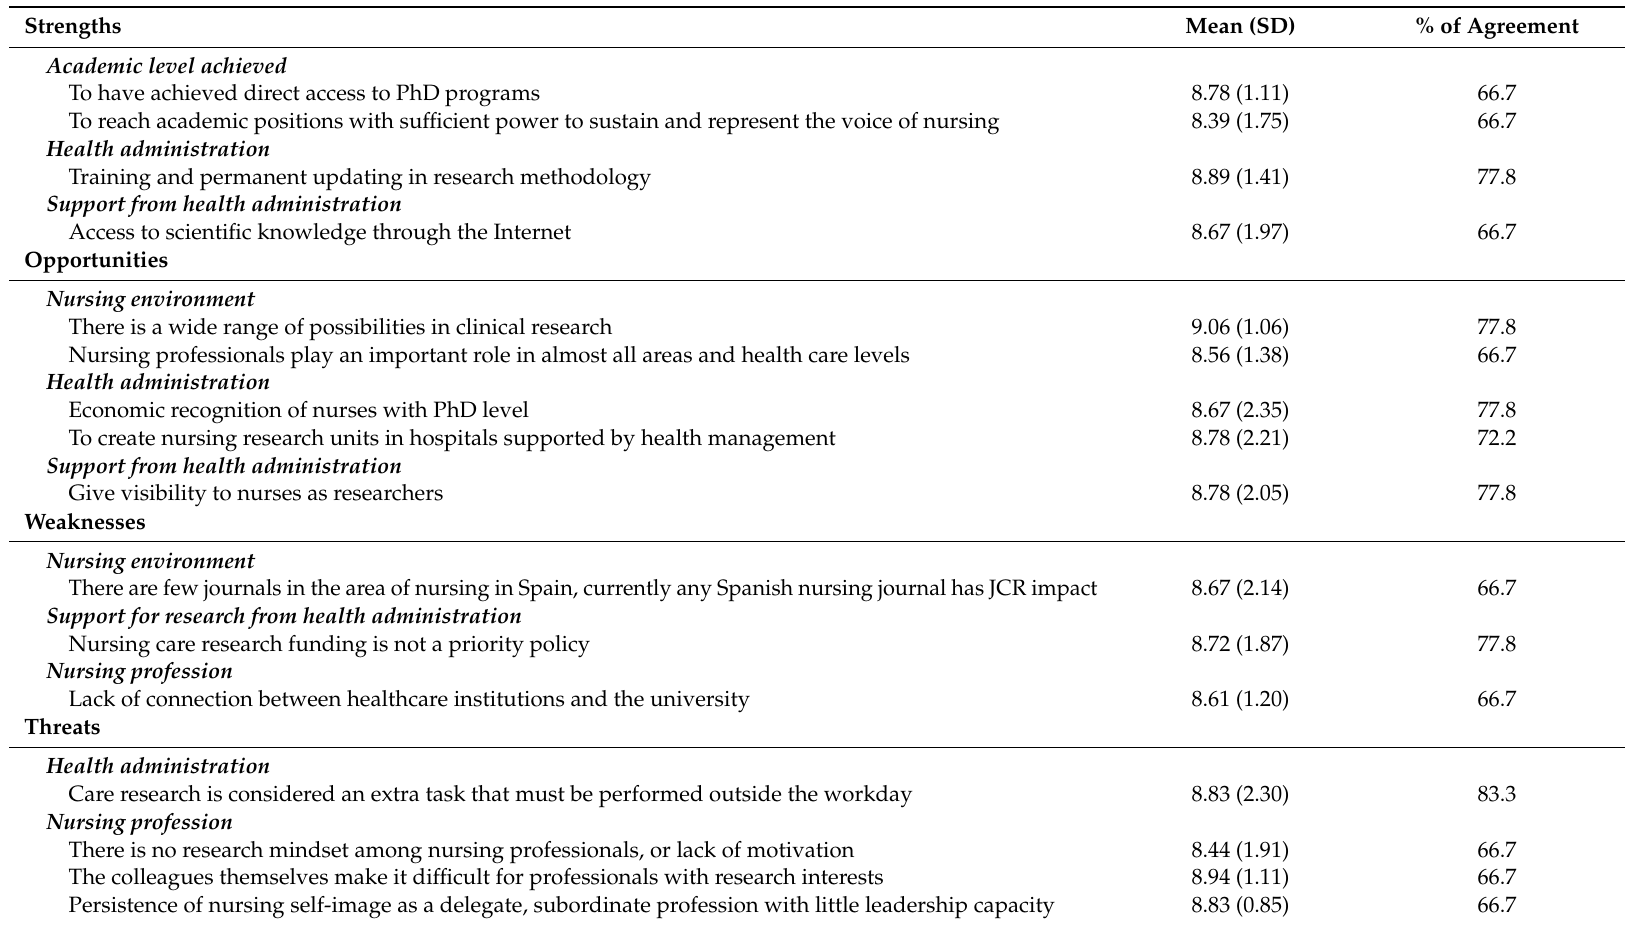
Table 2. High-consensus statements after round